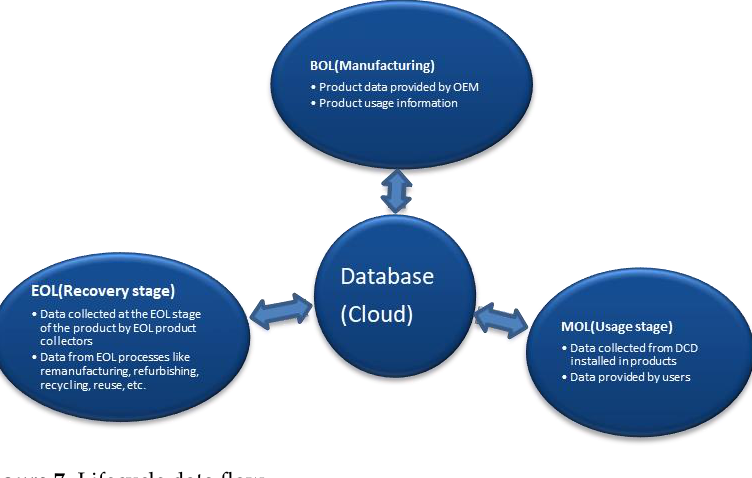
Figure 7. Lifecycle data flow .